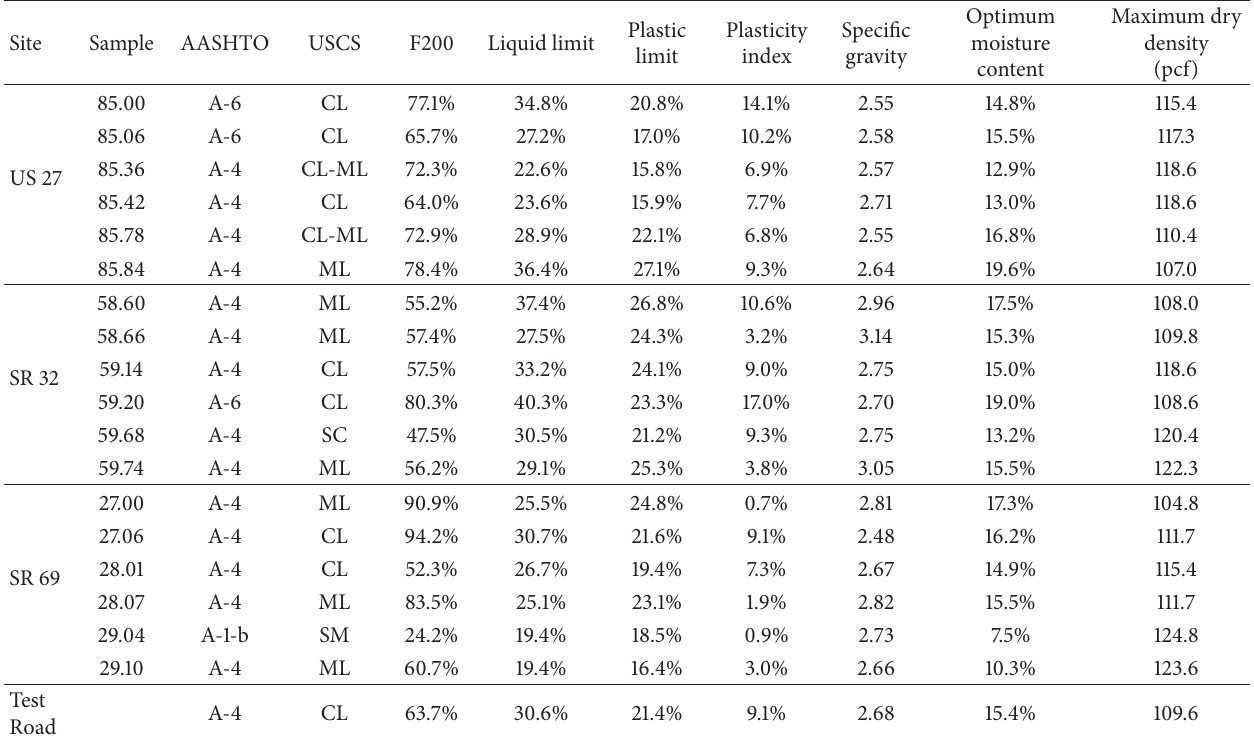
Table 5: Material properties for soils used.